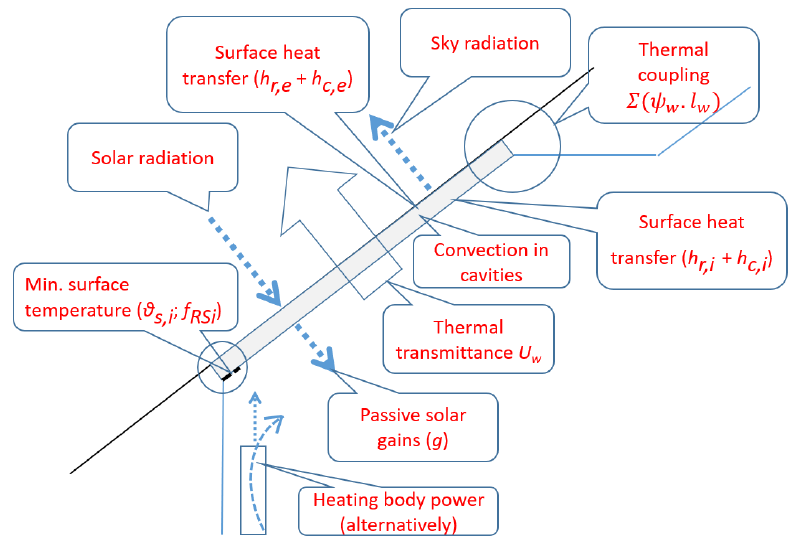
Figure 1. Significant thermal phenomena related to roof windows.